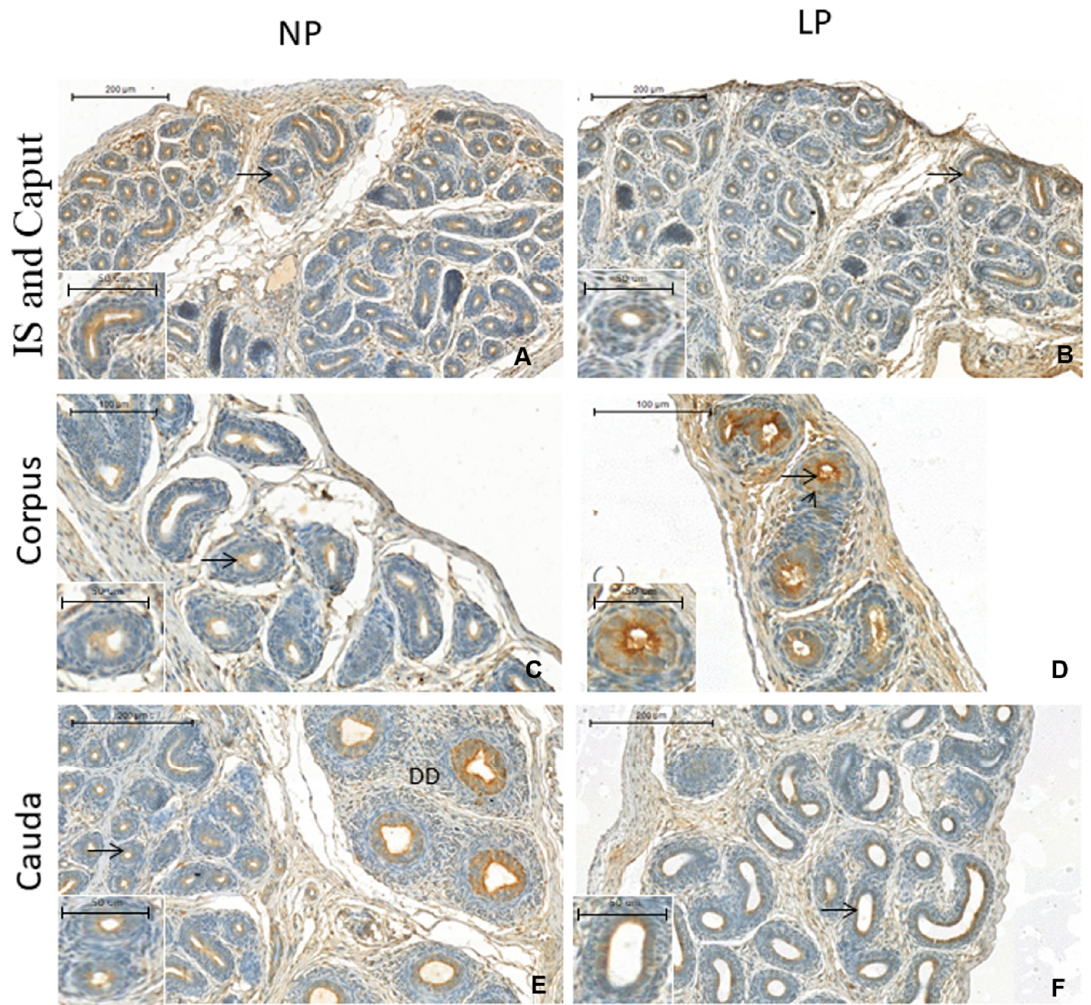
Figure 5. Epididymis sections of the initial segment (IS), caput regions, corpus and cauda from the NP and LP animals at PND14 subjected to AQP9 immunostaining. NP = normoprotein animals; LP = low-protein animals. ( A ) (IS and Caput from NP group); ( B ) (IS and Caput from LP group); ( C ) (Corpus from NP group); ( D ) (Corpus from LP group); ( E ) (Cauda from NP group); ( F ) (Cauda from LP group). Arrow = Positive staining for AQP9.